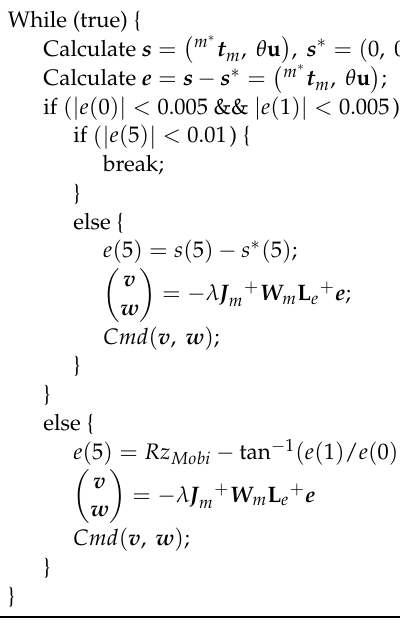
Algorithm 2 Pseudocode of the visual-servo control of the mobile